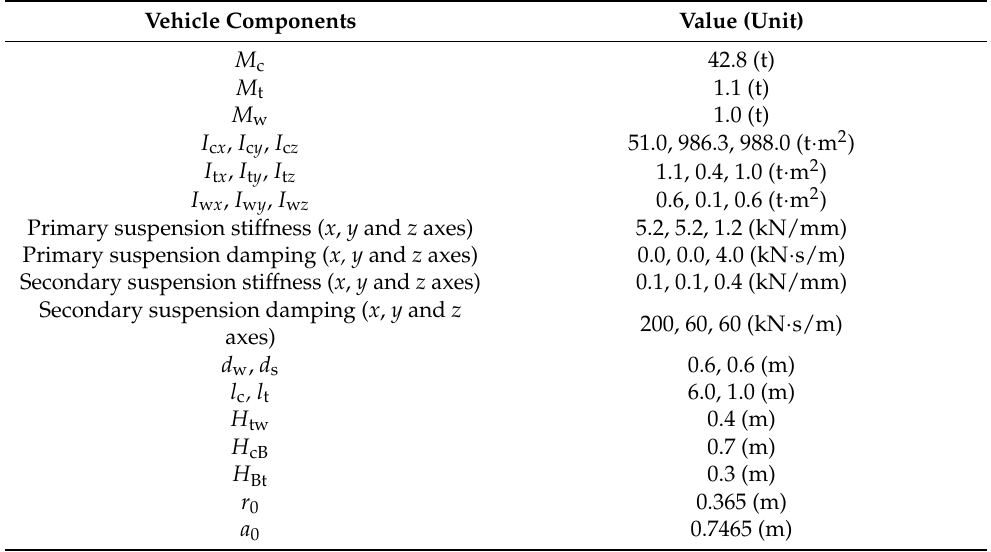
Table 2. The key parameters of the vehicle. Vehicle Components